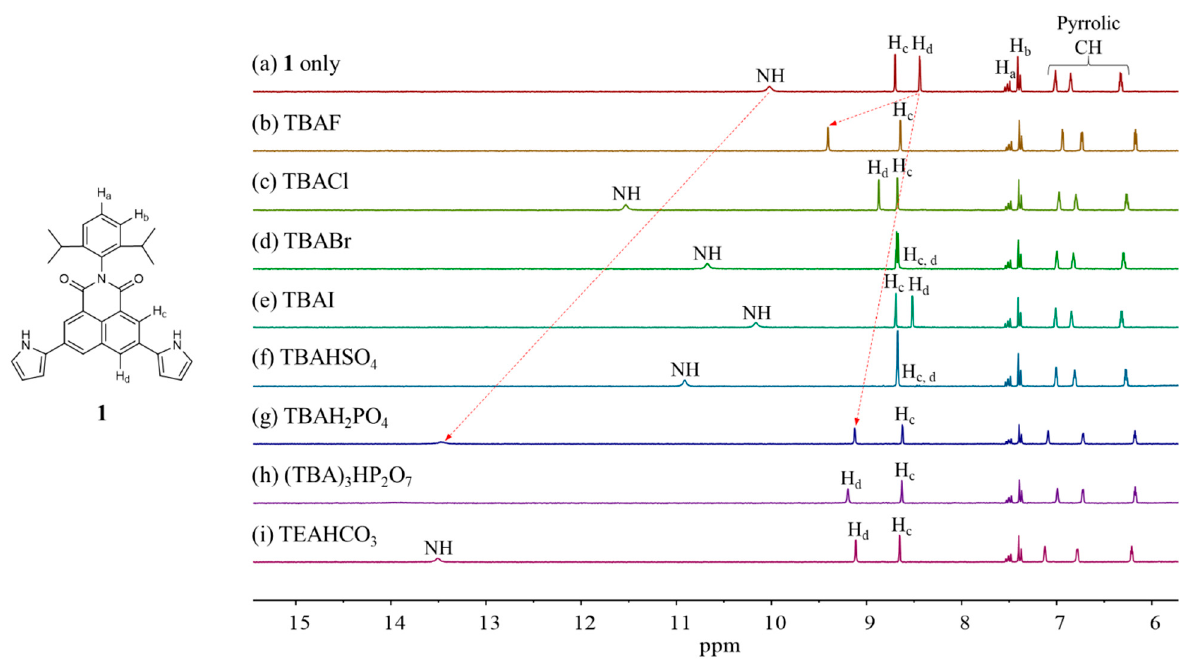
Figure 4. Partial 1 H NMR spectra of (a) 1 (3 mM) only, (b) 1 + excess TBAF, (c) 1 + excess TBACl, (d) 1 + excess TBABr, (e) 1 + excess TBAI, (f) 1 + excess TBAHSO 4 , (g) 1 + excess TBAH 2 PO 4 , (h) 1 + excess (TBA) 3 HP 2 O 7 , and (i) 1 + excess TEAHCO 3 in CD 3 CN.